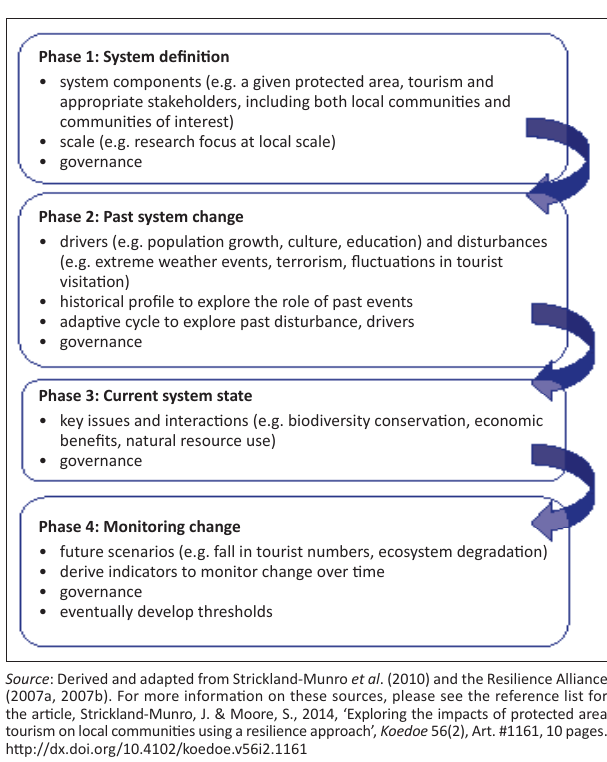
FIGURE 2: Conceptual framework for investigating the relationship between protected area tourism and local communities.